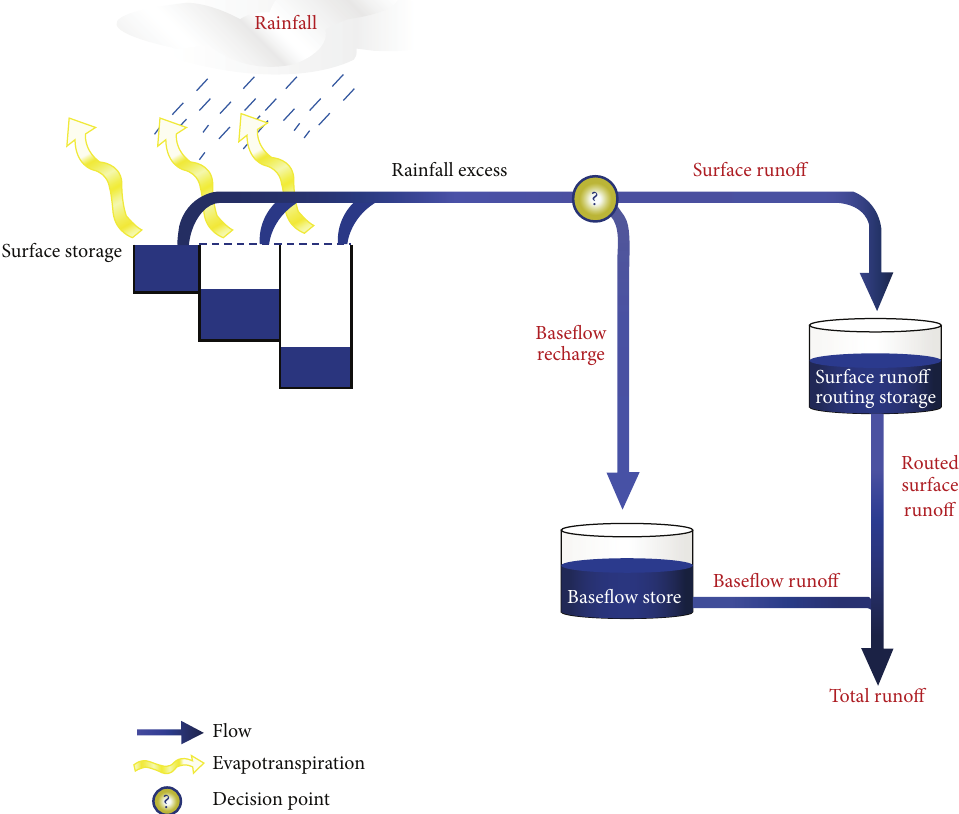
Figure 14: The AWBM structure (Source: RRL [39]).